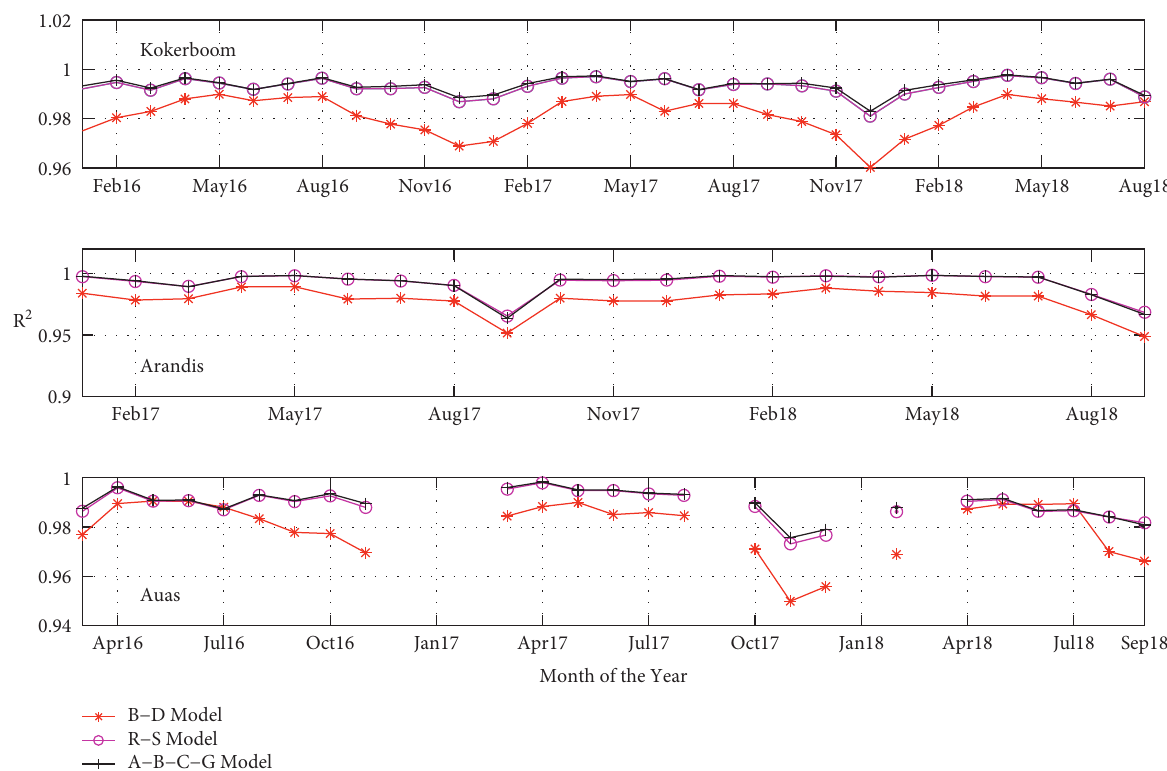
Figure 8: Monthly coefficients of determination, R 2 , values for Kokerboom, Arandis, and Auas.